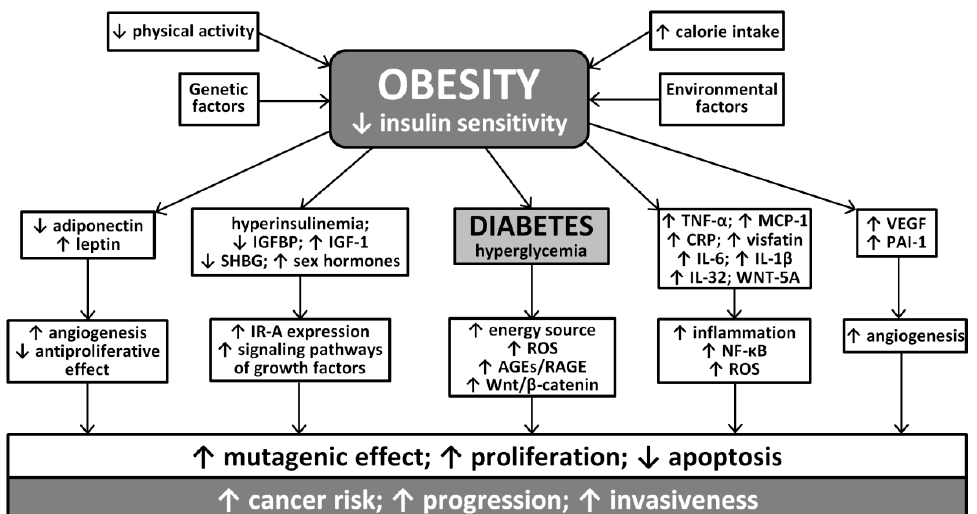
Figure 2. A simplified view of the relationship between obesity, diabetes and related metabolic disorders and cancer risk (based on [29–37,43–48,63–66]). IGFBP—insulin-like growth factor binding protein; SHBG—sex hormone binding globulin; VEGF—vascular endothelial growth factor; PAI-1—plasminogen activator inhibitor-1; TNF- α —tumor necrosis factor- α ; MCP-1—Monocyte Chemoattractive Protein-1, CRP—C-reactive protein; IL-6—interleukin-6; IL-1 β —interleukin 1 β ; IL-32—interleukin-32; IR-A—insulin receptor A; ROS—reactive oxygen species; AGE—advanced glycation end-products; RAGE—receptor for AGE; NF- κ B—nuclear factor kappa B.